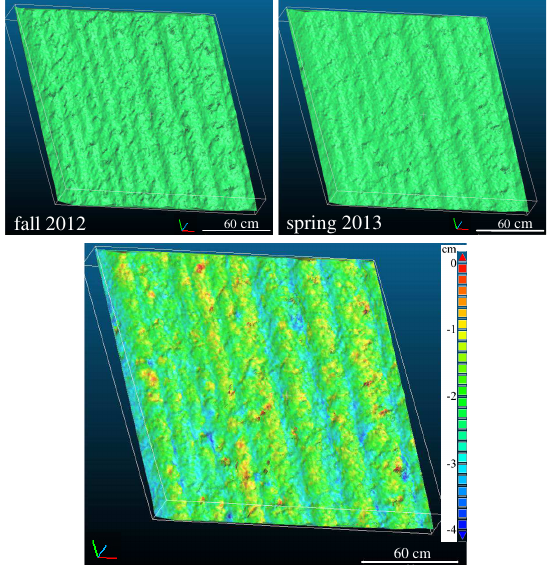
Figure 6. Change detection at the Saxonian plot, unit [m] At the study plot in Andalusia different events are apparent (Figure 7). The long-term observation from fall to spring exhibits surface lifting mainly due to swelling at the clayey position while the short-term single precipitation event surveillance indicates small rill developments and laminar soil particle movement.